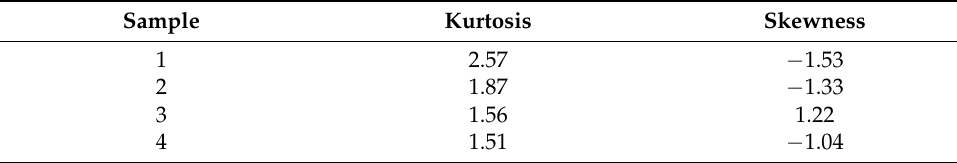
Table 4. The values of kurtosis and skewness for all samples. Sample Kurtosis